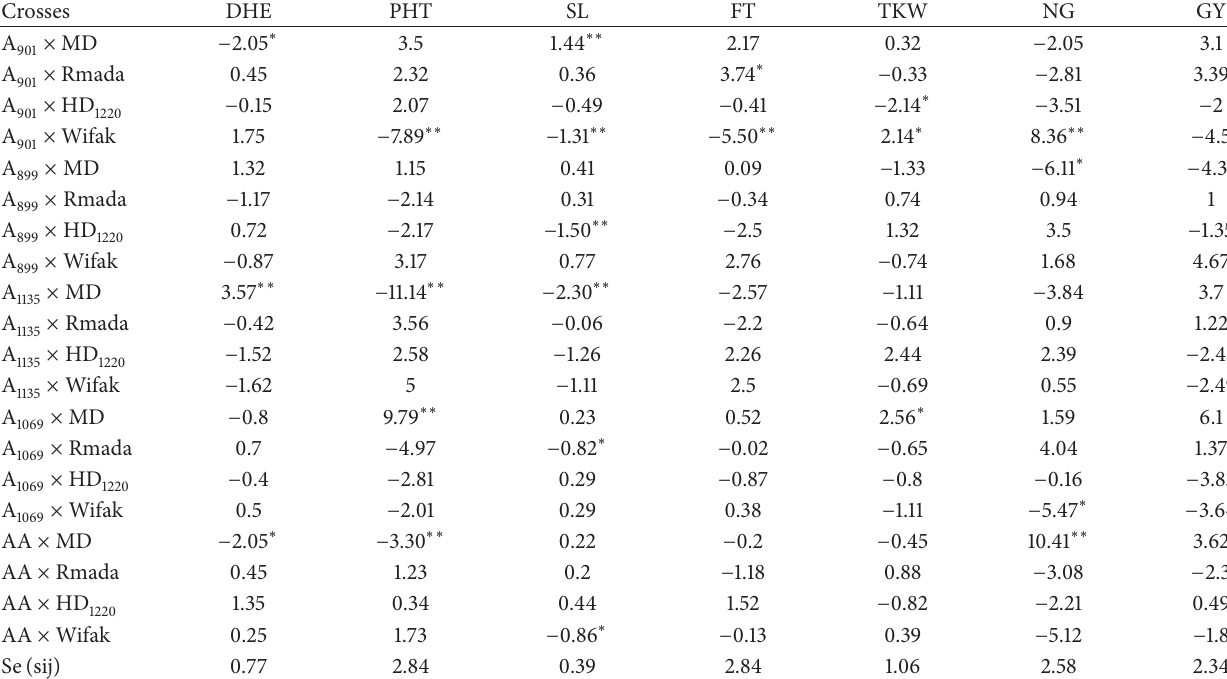
Table 5: Specific combining ability (sij) effects for characters in bread wheat hybrids.